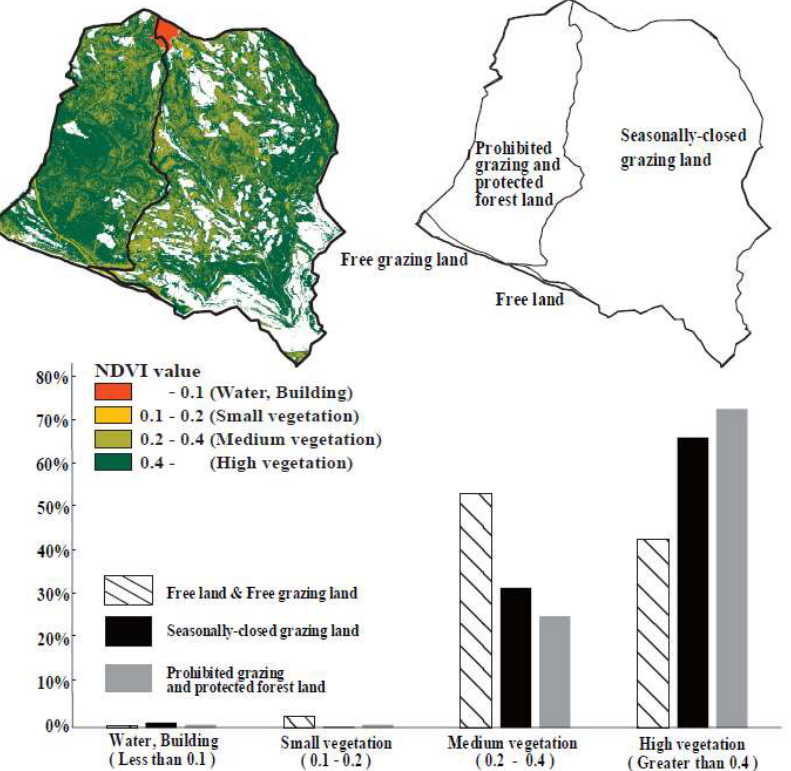
Figure 5. Ratio of normalized difference vegetation index (NDVI) values in each land management type in the Adi Zaboy watershed in September 2016.